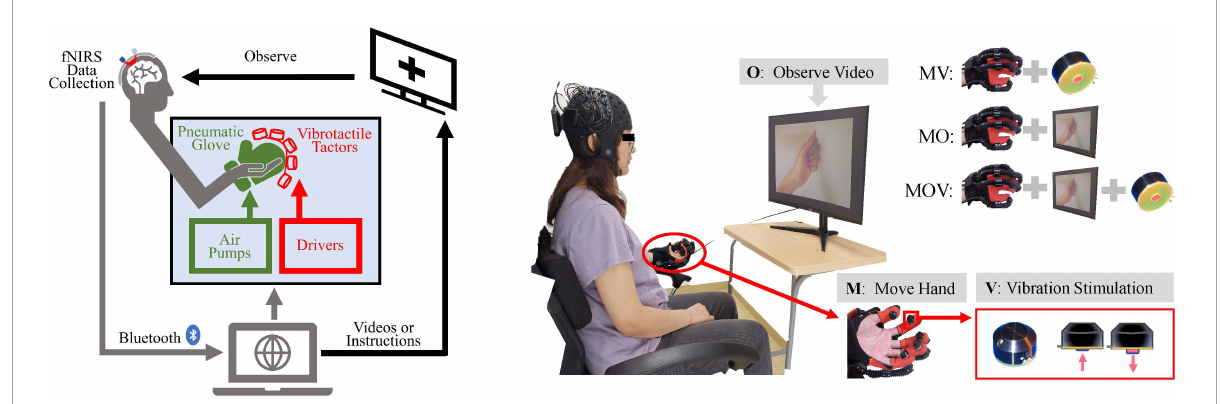
FIGURE1 Schematic diagram of the experimental setup and paradigm. (A) Experimental system setup: left, functional near-infrared spectroscopy (fNIRS) data acquisition device; middle, vibrotactile enhanced pneumatically actuated hand rehabilitation device, consisting of a pneumatic glove rehabilitation module and a vibrotactile actuators; right, motion video and command display. Multiple devices were controlled synchronously using Python scripts and through USB serial communication. (B) The “O” represents observing the video, “M” represents moving the left hand with the pneumatic glove, and “V” represents vibrotactile stimulation to the abdomen of five fingertips. The tasks for the left hand consisted of Move Hand and Vibration Stimulation (MV), Move Hand and Observe Video (MO), Move Hand and Observe Video and Vibration Stimulation (MOV), and contrast task (Rest). The screen displays a cross when the experimental task did not include a video of the hand clenching motion.